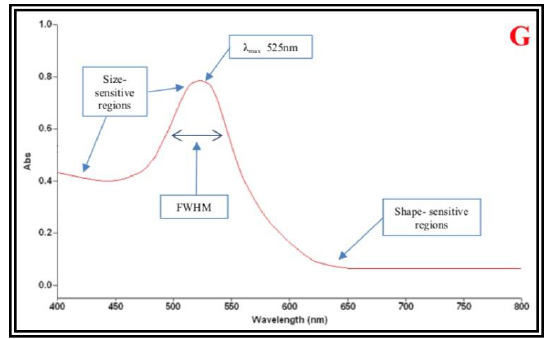
Figure 2. UV scan of gold nanoparticles (G) Atomic force microscopy measurement AFM 3D image (Figure 3) and particle size distribution (Figure 4) of gold nanoparticles (G) showed a smooth surface with fine particles distribution. The average particles size was 24.35nm with distribution 23.98%. These results supported the data of UV-Visible spectroscopy .